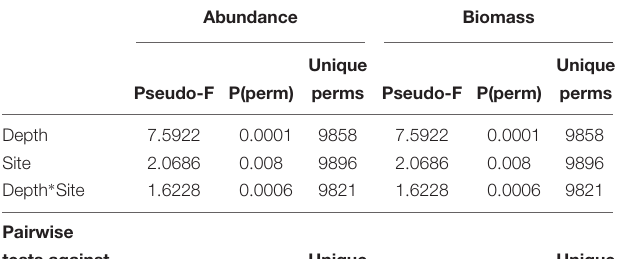
DISTLM analysis indicated significant relationships